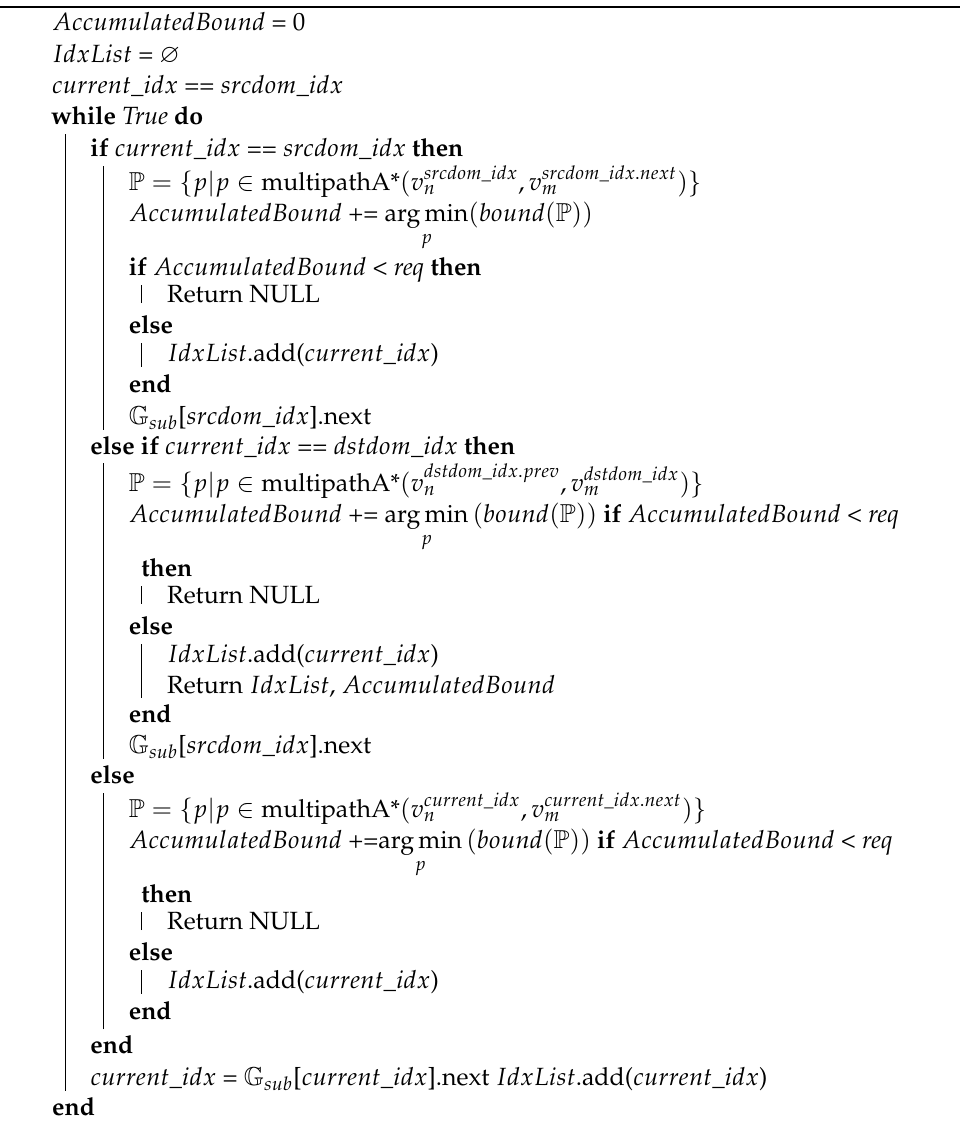
Algorithm 2: Inter-domain flow path